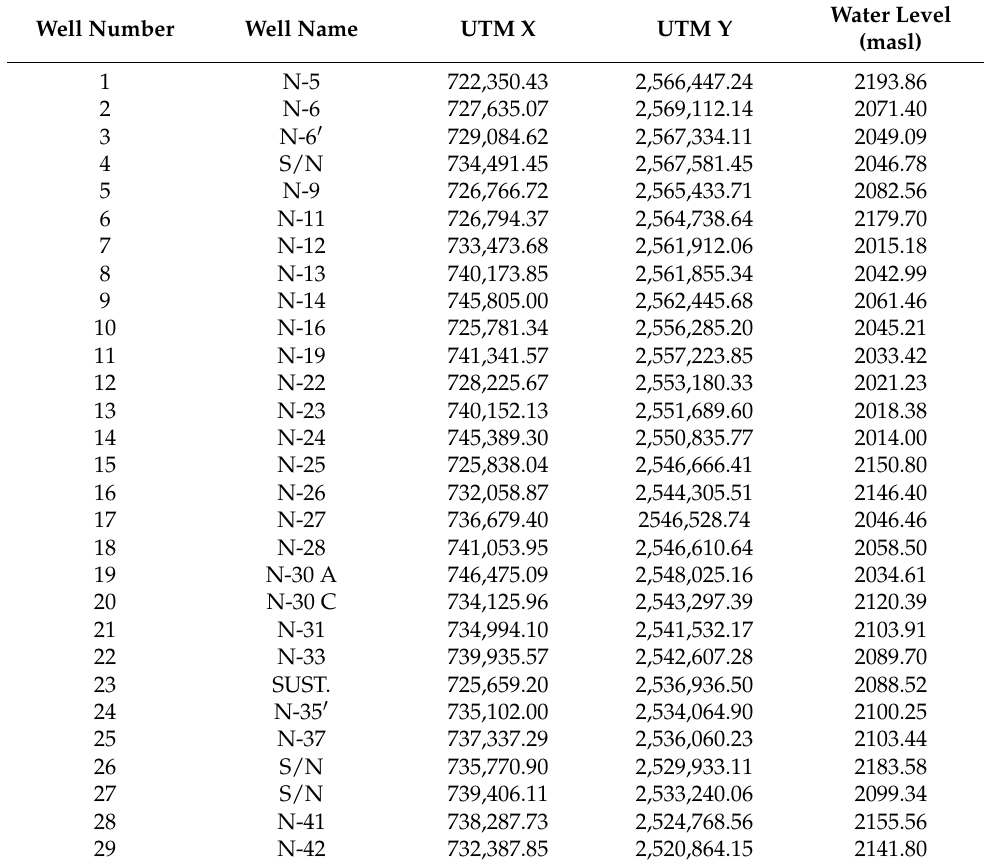
Table A1. Location of the monitoring network and groundwater levels for the Calera aquifer